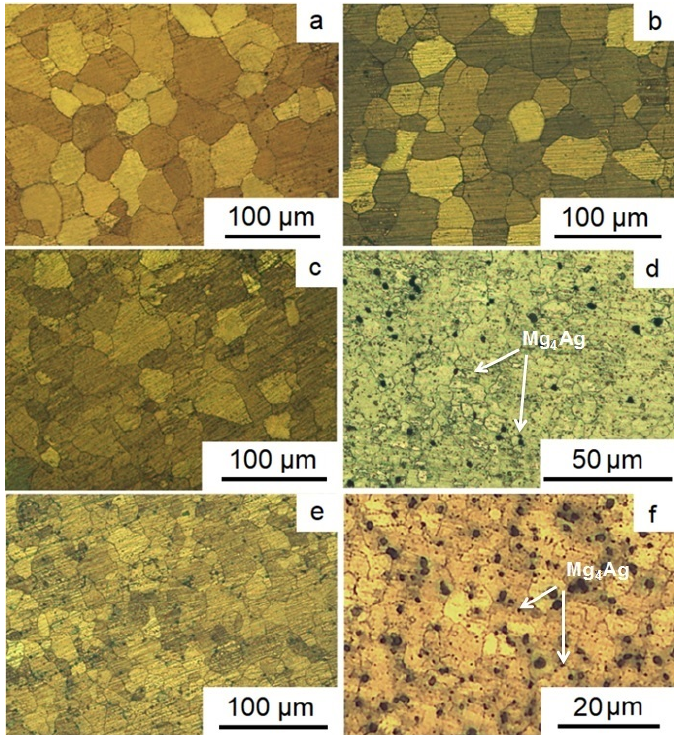
Figure 2. Structure of Mg-2.0%Ag ( a , c , d ) and Mg-4.0%Ag ( b , e , f ) alloys in the initial state ( a , b ) and after ECAP according to the first ( c , e ) and second ( d , f ) processing regimes.